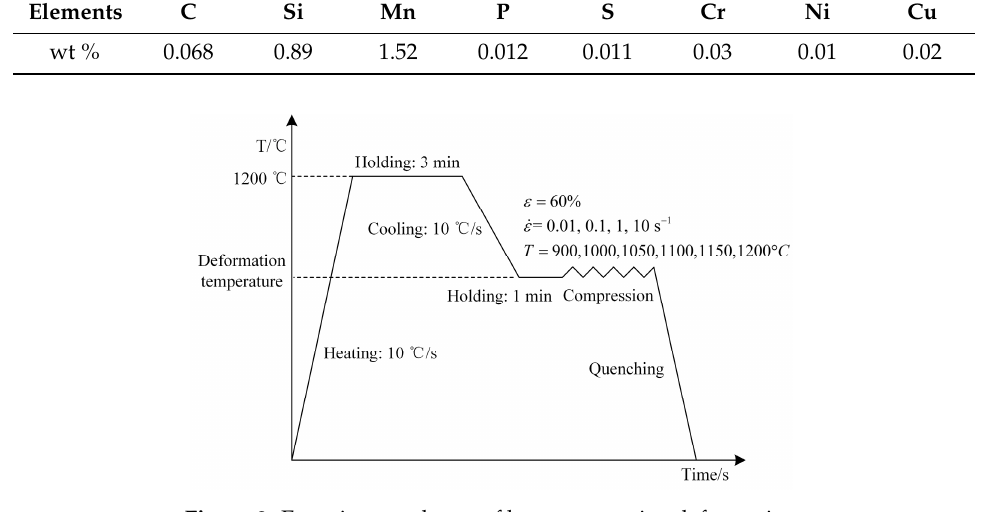
Figure 2. Experiment scheme of hot compressive deformation.